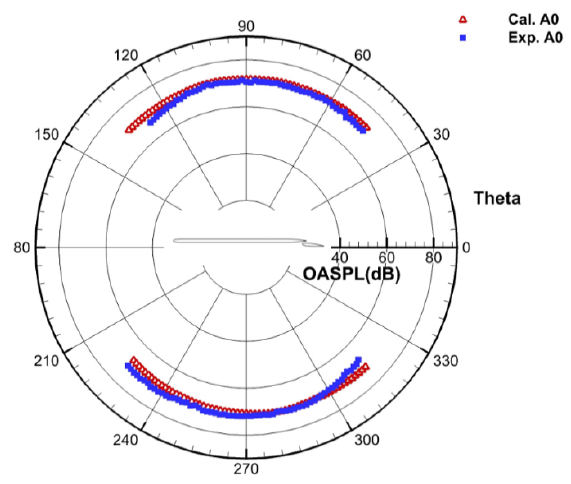
Figure 8. Sound pressure levels of probes in far field.